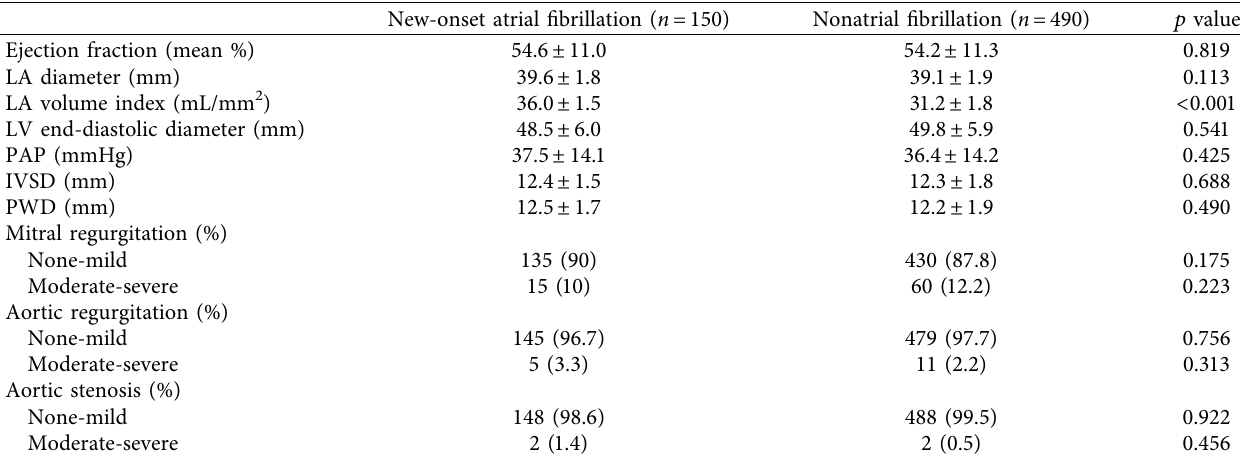
Table 2: Echocardiographic parameters of the patients.